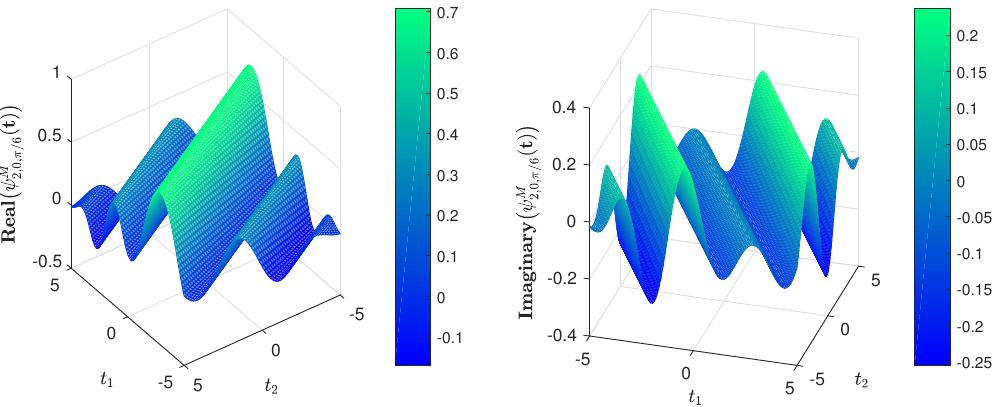
Figure 2. The linear canonical ridgelet waveforms for M = ( 1,2;1/2,2 ) at scale a = 2, location b = 0, and orientation θ = π